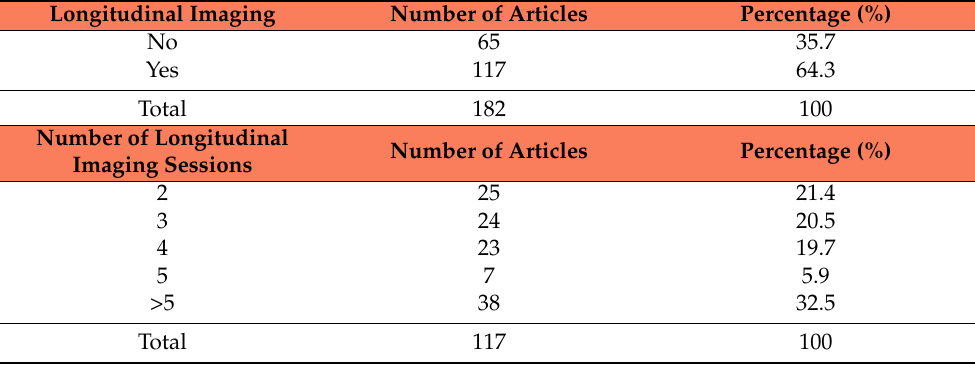
Table 6. Total number of imaging sessions performed within the same animal. Longitudinal imaging was considered being two or more imaging occasions, enabling comparison of two various time points from the same